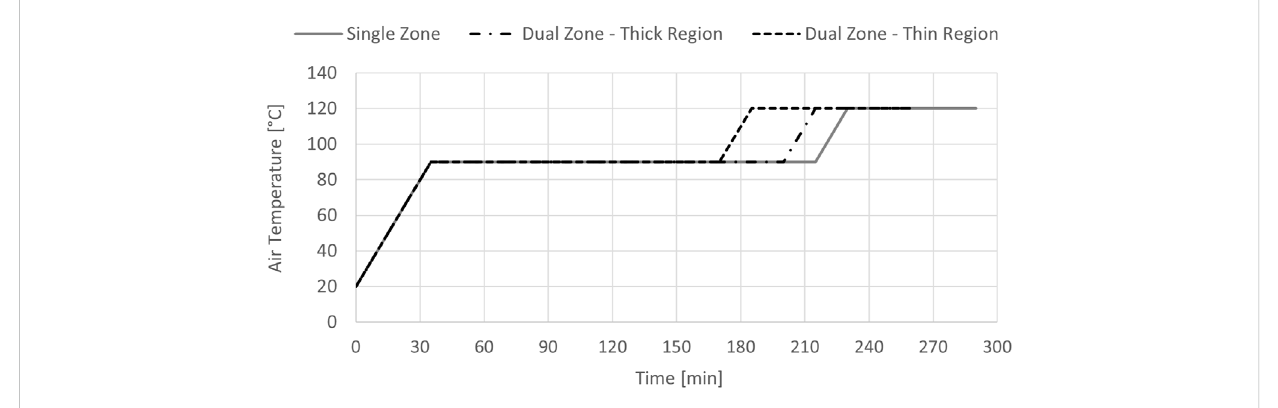
FIGURE 4 Air temperature pro fi les for single and dual